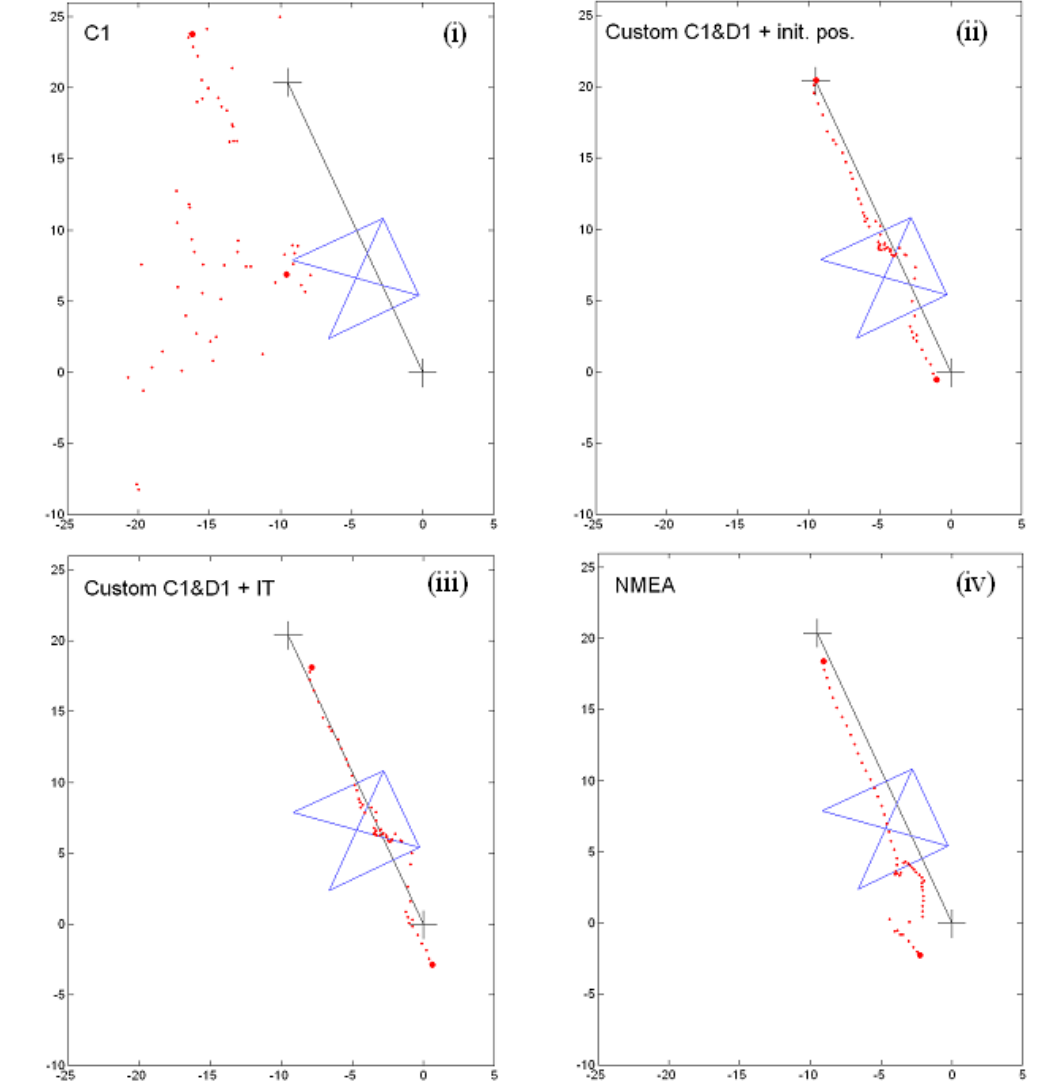
Figure 6. Solutions in a mixed-condition environment (d): (i) autonomous C1